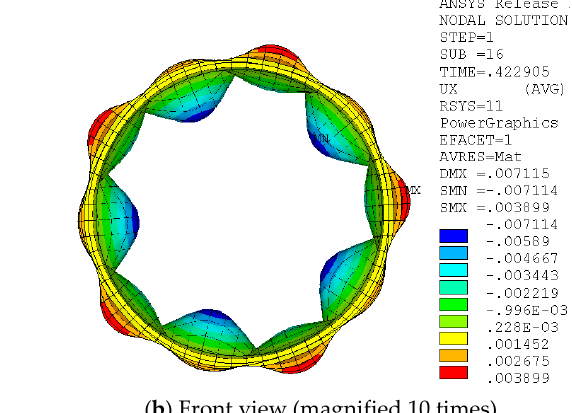
Figure 5. Radial displacement contour map at the critical point of the post-buckling path for the model of the stiffened cylinders with L / R = 2.51 and the SS3 boundary condition when the material is AL and ξ = 0.05.